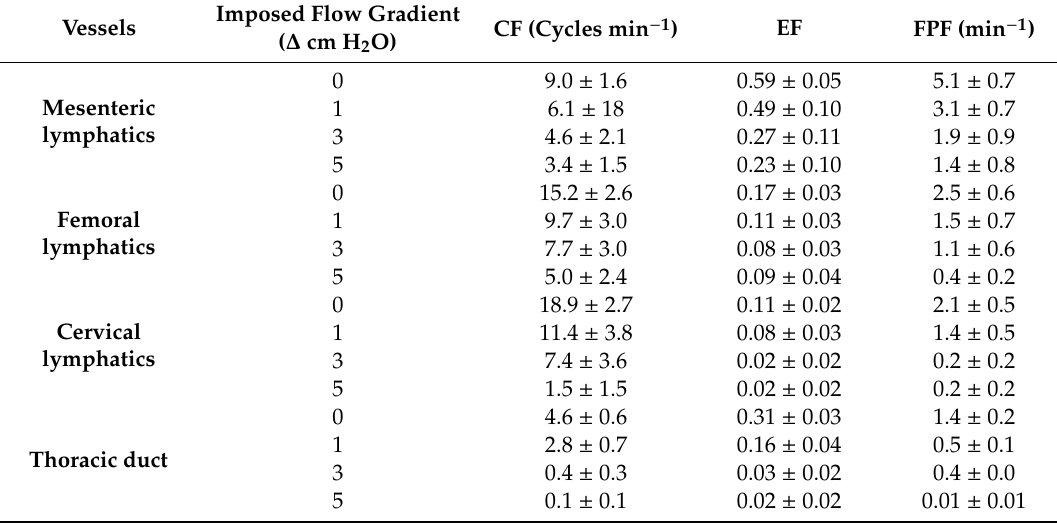
Table 1. E ff ect of imposed flow on intrinsic contractile activity of lymphatic vessels from di ff erent body areas of the